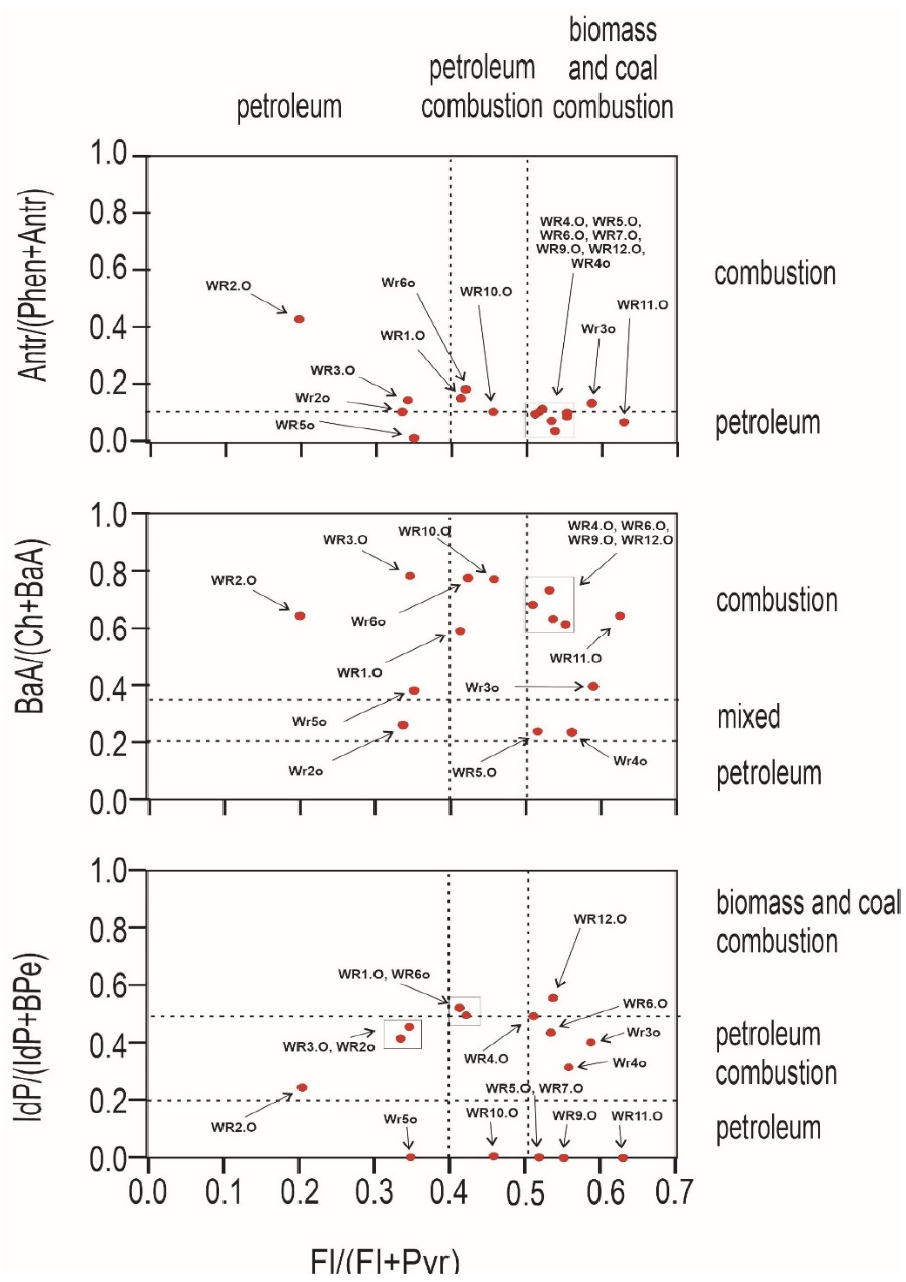
Figure 5. Diagnostics diagrams of PAHs in burnt waste investigated from wild waste dump in Trzebinia on S ł owackiego Street. A—anthracene, P—phenanthrene, Fl—fluoranthene, Py—pyrene, BaA—benzo(a)anthracene, Ch—chrysene, IP—indeno(1,2,3-cd)pyrene, BghiP—